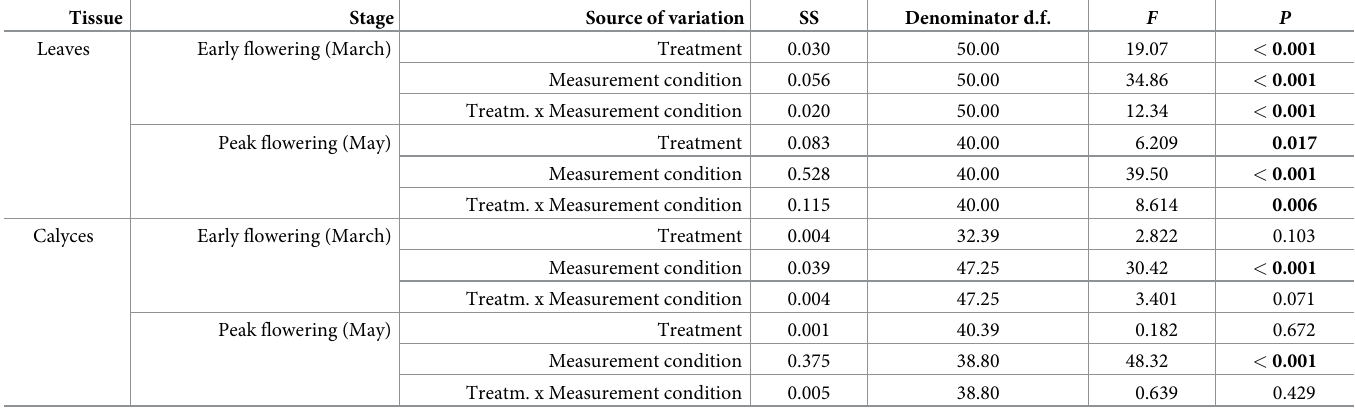
Table 2. Results from GLMMs testing the effect of UV radiation, measurement condition (predawn or afternoon) and their interaction on the photochemical effi- ciency of PSII ( Fv/Fm ) in leaves and calyces. Tissue